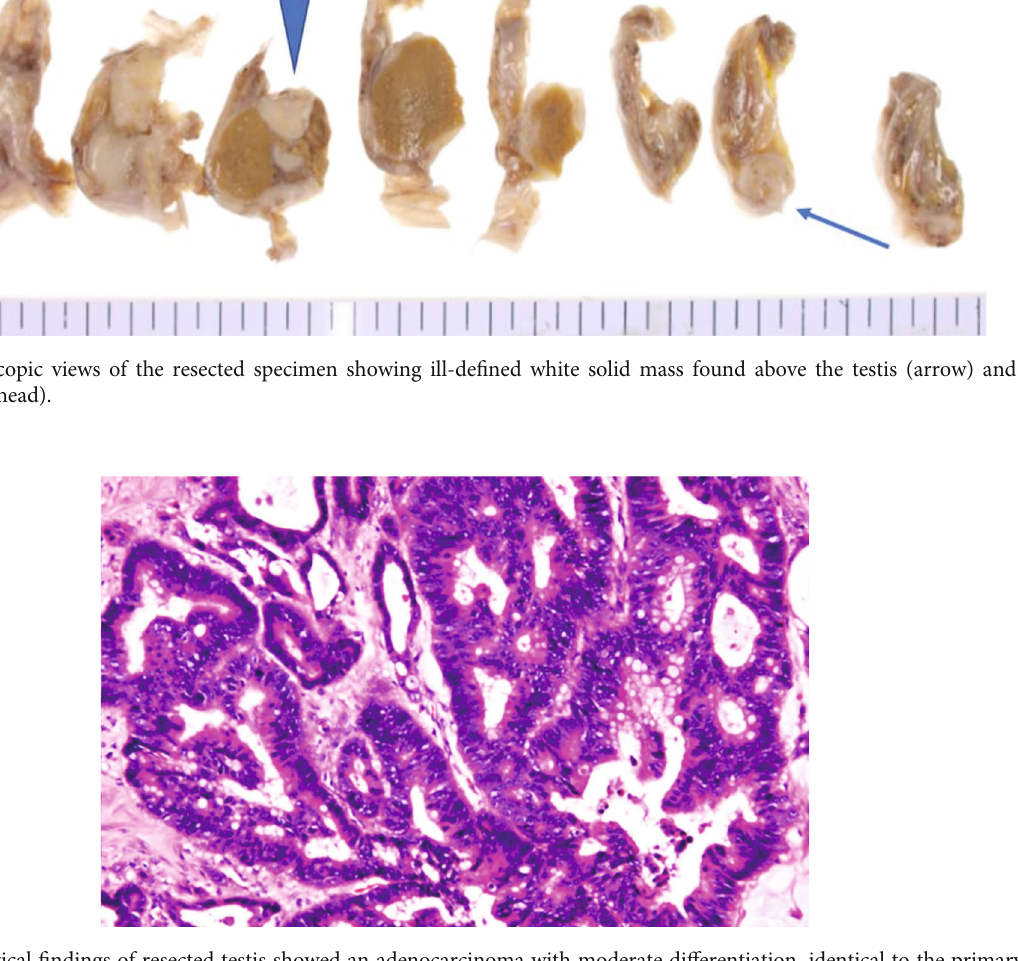
Figure 4: Histological fi ndings of resected testis showed an adenocarcinoma with moderate di ff erentiation, identical to the primary colon cancer (H&E stain, ×